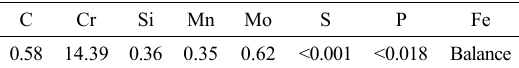
Table 1. Chemical composition in % weight of DIN 1.4110 martensitic stainless steel of work